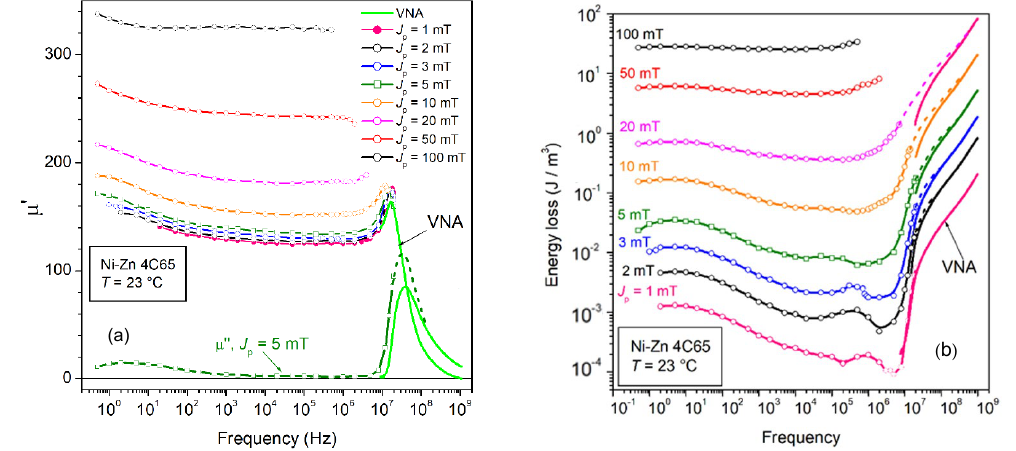
Figure 17. ( a ) The frequency dependence of μ ′ ( f ) in the Ni-Zn ferrite 4C65 demonstrates the existence of a relaxation effect, whose average time constant is τ ~0.1 s. It is a thermally assisted process of diffusion, which interferes with the motion of the dws and gives rise to relevant extra losses, as shown in ( b ). A maximum loss value is attained at a frequency f 0 = 1/2 πτ . A further loss contribution, peaking between 100 kHz and 1 MHz is observed at J p values lower than 10 mT. This could derive from dw resonance and the related energy absorption. The dashed lines in these figures are reason- able interpolations, which cover those high-frequency intervals that cannot be tested by fluxmetric methods and, having residual dw contributions, do not coincide with the VNA results (solid lines).